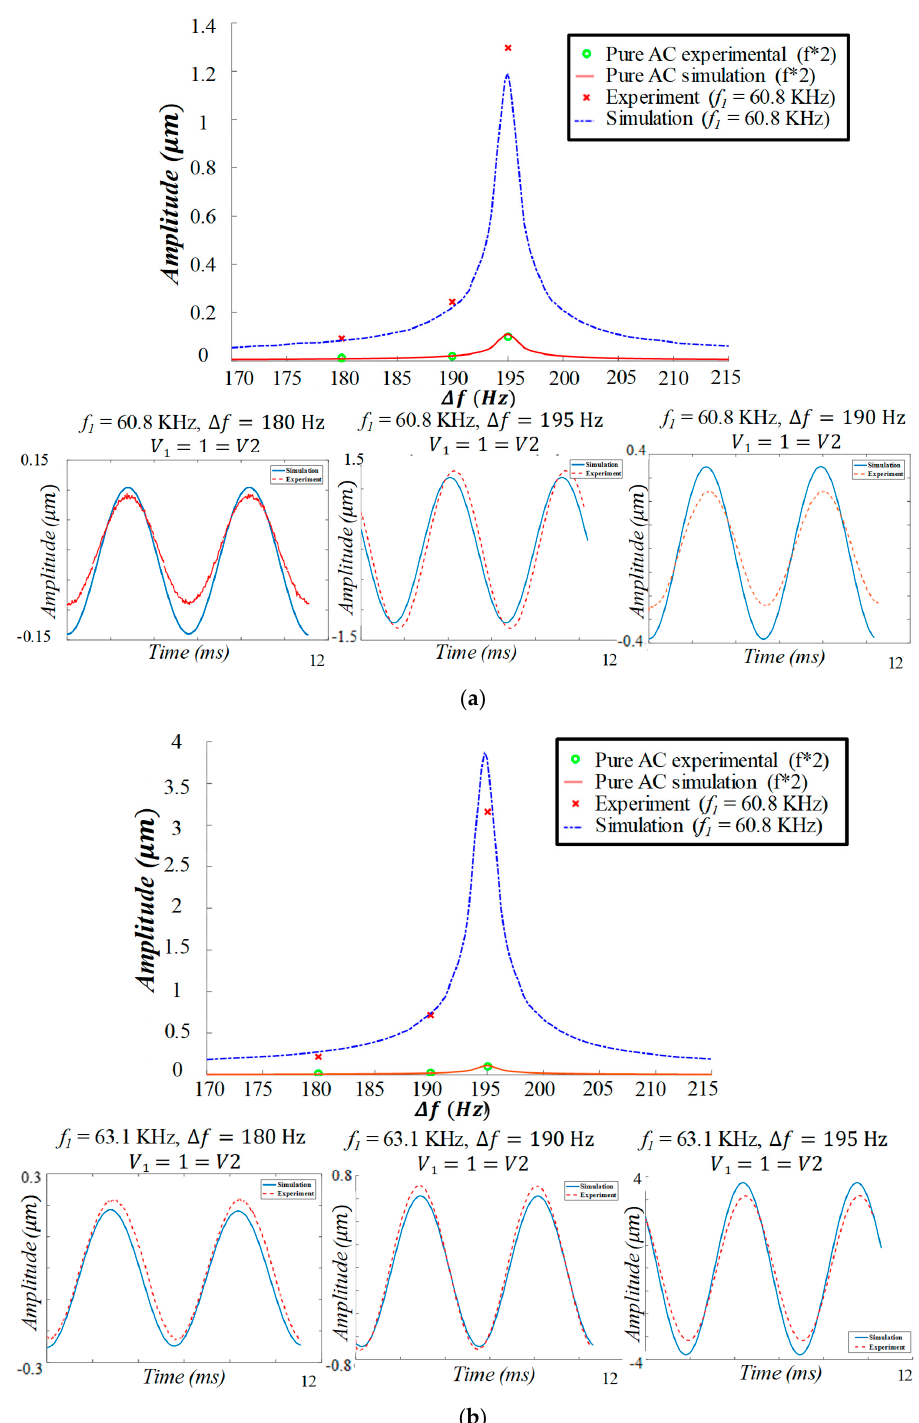
Figure 6. Double resonance excitation using a beating signal composed of two voltage sources each with an amplitude of 1 V: ( a ) a frequency of f 1 = 60.8 kHz and ( b ) a frequency of f 1 = 63.1 kHz and f 2 is swept both cases. Experimental results are shown with crosses and simulation is shown by a dashed line. Both cases are compared to the experimental and numerical simulation frequency response when excited classically by a single AC source at a frequency range of 85–107.5 Hz at 2 V, which has a maximum amplitude of 0.1 µ m. This is denoted by the label “2 f ” to indicate that the effective frequency due to a single AC source is double the input frequency (frequency